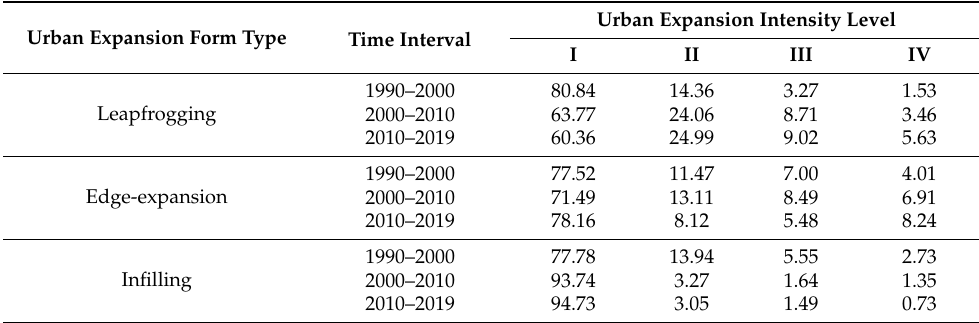
Table 4. The proportion of urban expansion intensity levels for different urban expansion forms from 1990 to 2019 (%).